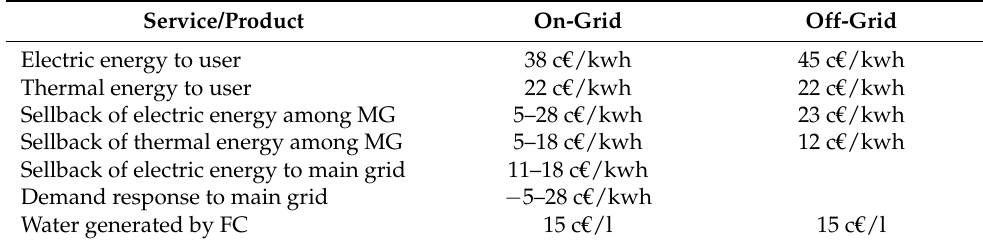
Table 2. Price structure of the services offered with CHP-MMG. Service/Product